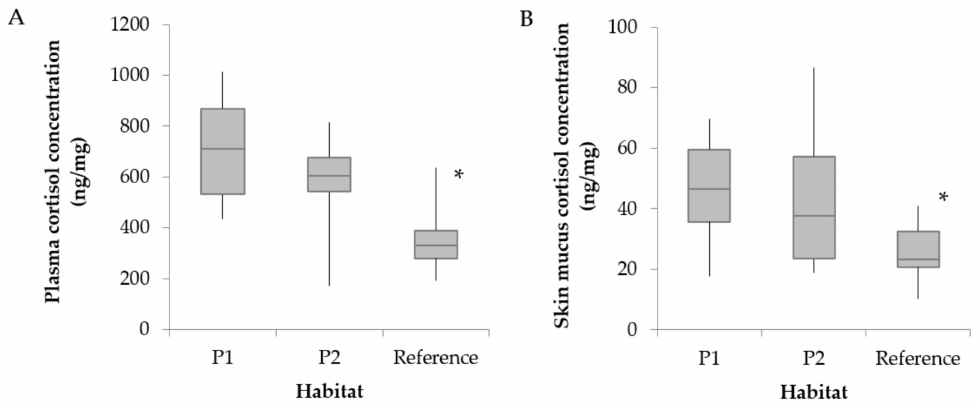
Figure 3. Cortisol concentrations in ( A ) plasma and ( B ) skin mucus of the Catalan chub sampled at two polluted sites (P1, n = 6; P2, n = 17) and a reference non-impacted upstream site (n = 22) in the Bes ò s River. Asterisks (*) indicate statistically significant di ff erences between habitats ( p <